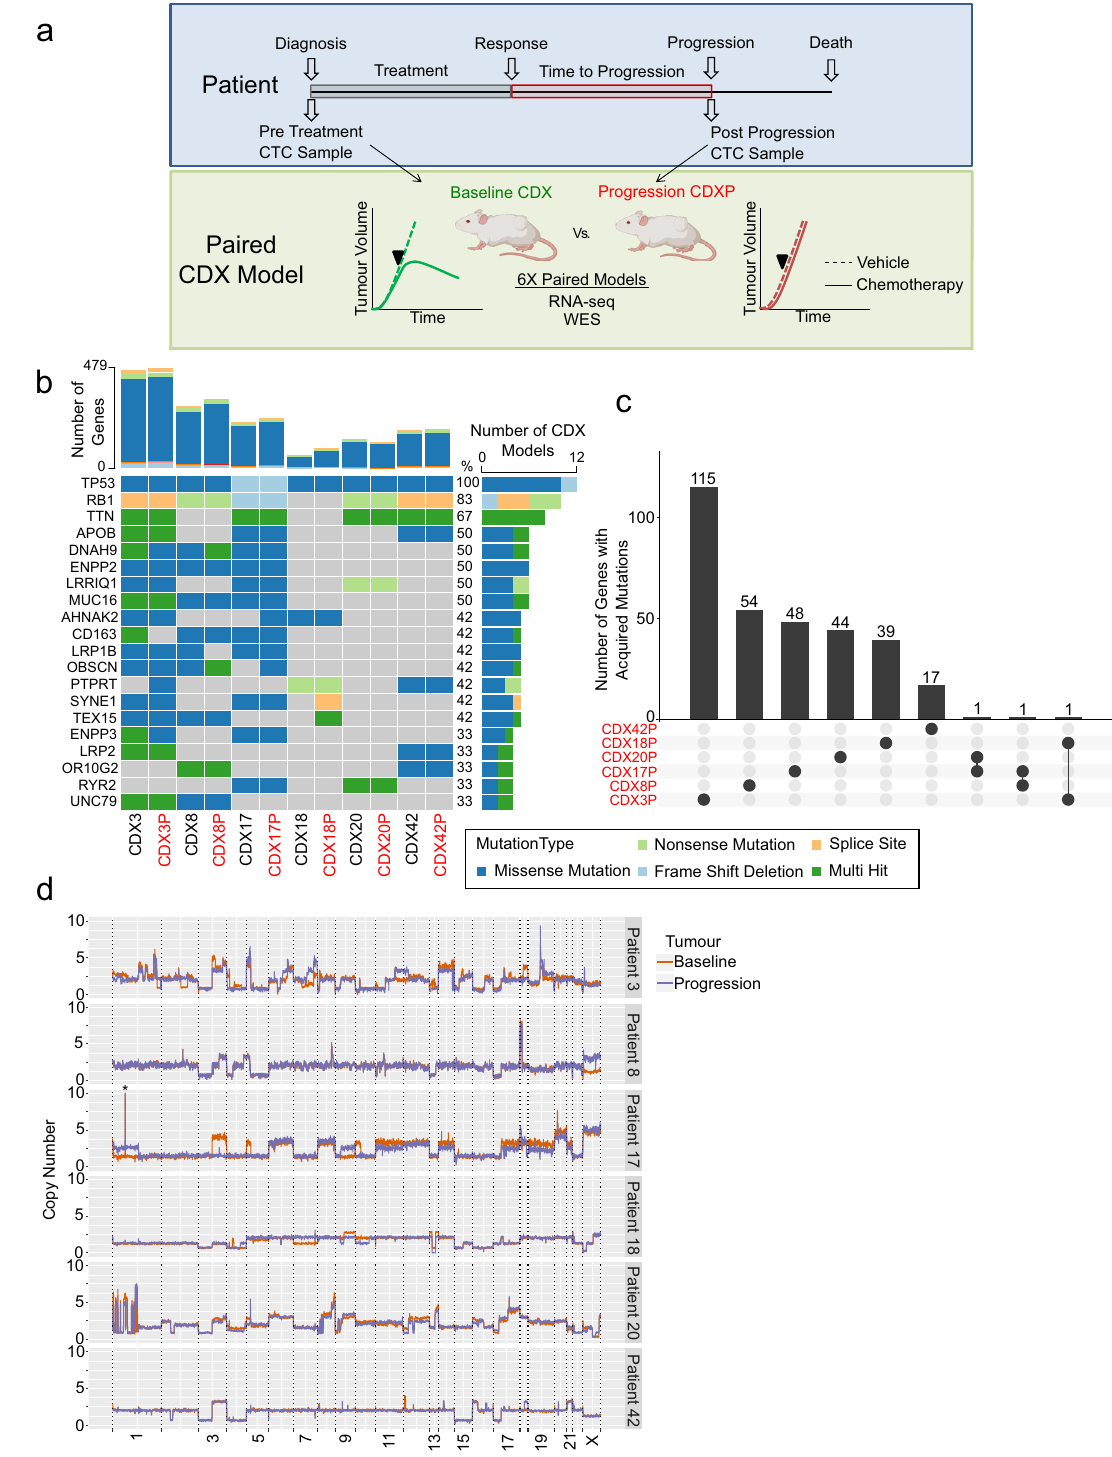
studies to investigate changes in the transcriptomes of pre- and post-chemotherapy CDX models. sGCs are upregulated during disease progression and correlate with acquired rather than inherent chemoresistance in SCLC . Previous studies suggested that acquired chemoresistance in SCLC can be driven through acquisition of transcriptional changes rather than emergence of recurrent mutations 5,19